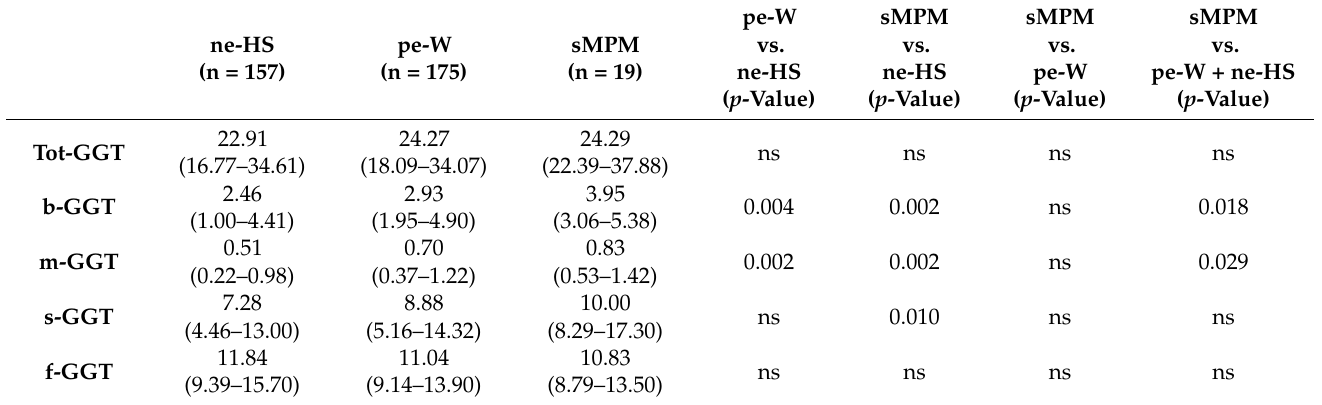
Table 2. Summary of the analysis of GGT fractions distribution in non-exposed subjects (ne-HS), previously exposed workers (pe-W), and a subset of malignant mesothelioma patients (sMPM) for which information about concomitant conditions was available; data are expressed as